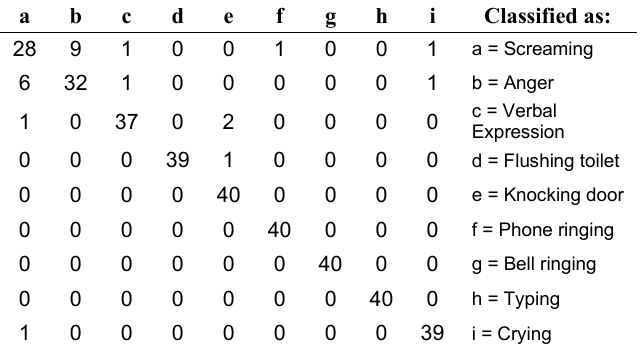
Table 3. Confusion matrix for SVM on the classification of the 9 audio classes and 10-fold